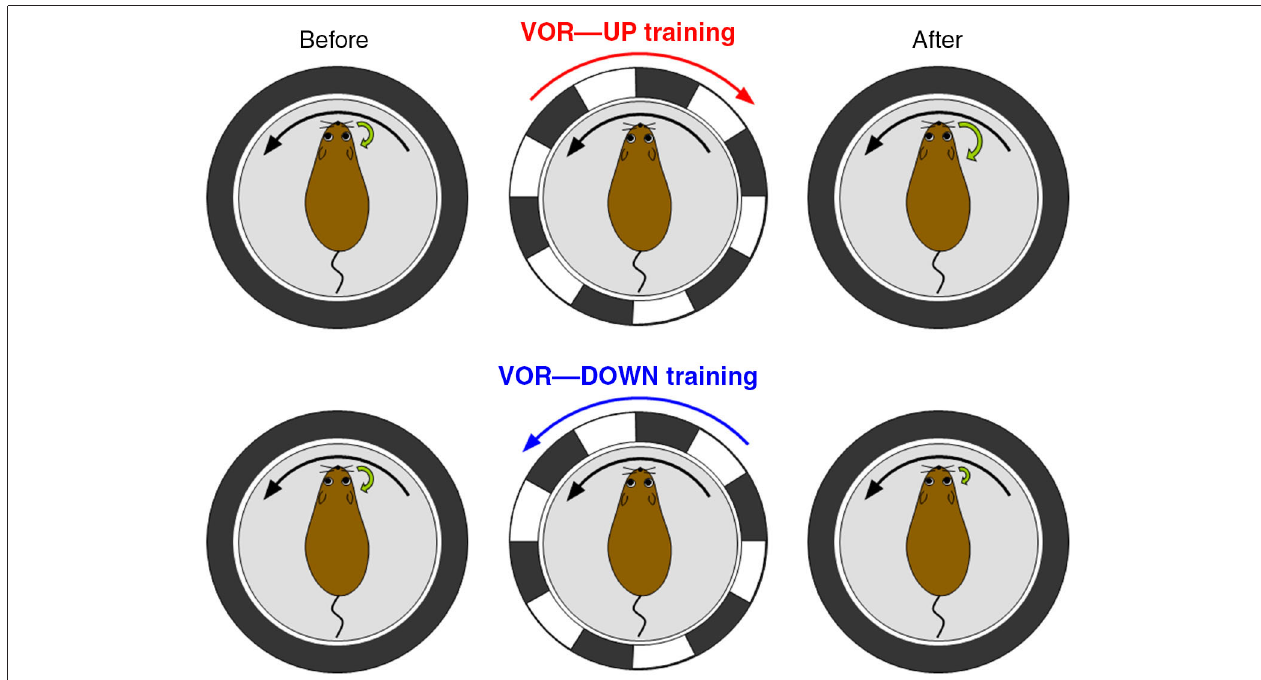
with vertical black and white stripes are rotated in opposite directions in the light (VOR-up training), the gain of VOR increases gradually. In contrast, when the rotations are in the same direction (VOR-down training), the gain